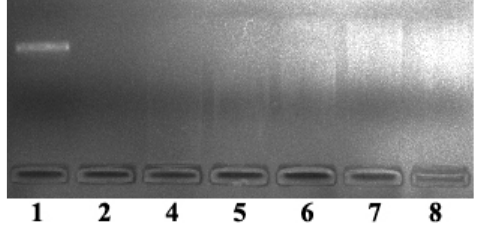
Figure 12. Electropherograms representing condensation and release of pUC19 plasmid DNA (0.008 µg/µL) in buffer of different weight ratios of GO to complex 2c (5 mM Tris-HCl/10 mM NaCl, pH = 7.4) at 37 °C. Lane 1 is DNA control, Lanes 2–8: 2c (6.25 × 10 − 5 mol/L), 2c (3.13 × 10 − 5 mol/L), 2c (6.25 × 10 − 5 mol/L)/GO (0.67 µg/µL), 2c (6.25 × 10 − 5 mol/L)/GO (1.34 µg/µL), 2c (3.13 × 10 − 5 mol/L)/GO (0.67 µg/µL), 2c (3.13 × 10 − 5 mol/L)/GO (1.34 µg/µL), respectively.